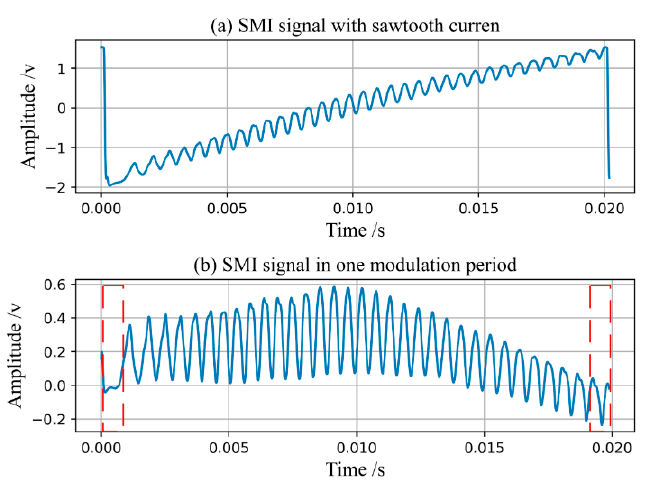
Figure 2. Schematic diagram of the experimental setup.